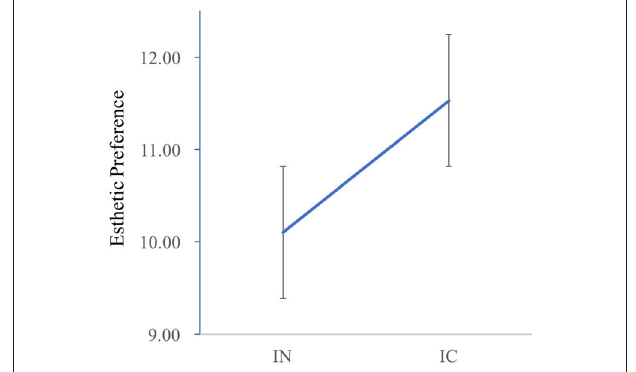
FIGURE 2 | Esthetic preference in the preliminary